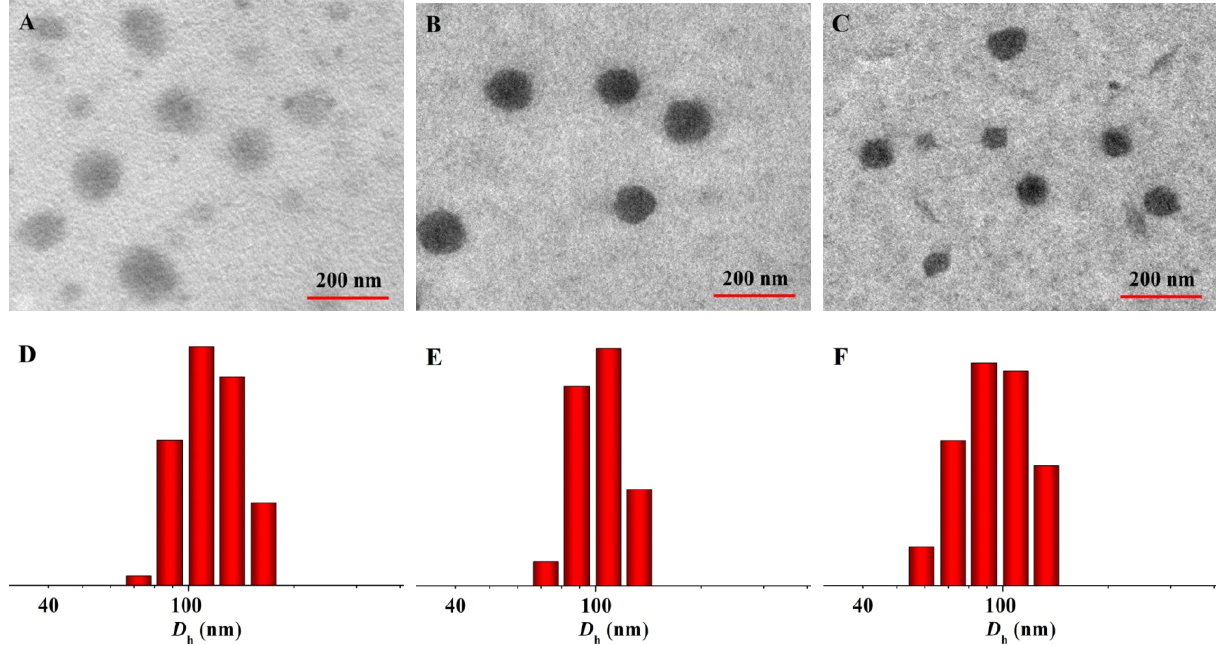
Figure 1. Typical TEM micrographs ( A – C ) and D h s ( D – F ) of CDM/DOX ( A and D ), CLM/DOX ( B and E ), and CSCM/DOX ( C and F